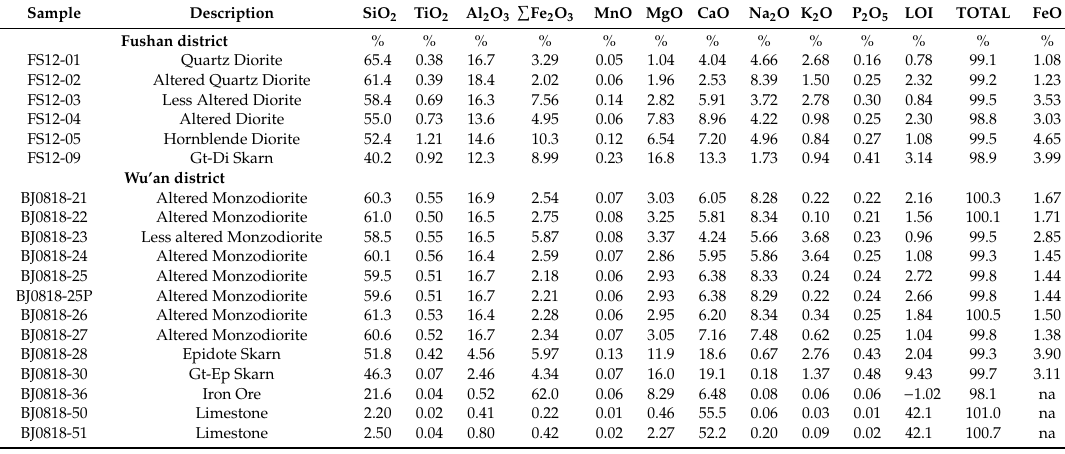
Table 2. Major elements concentration of whole rocks from the Han-Xing iron skarn deposit.